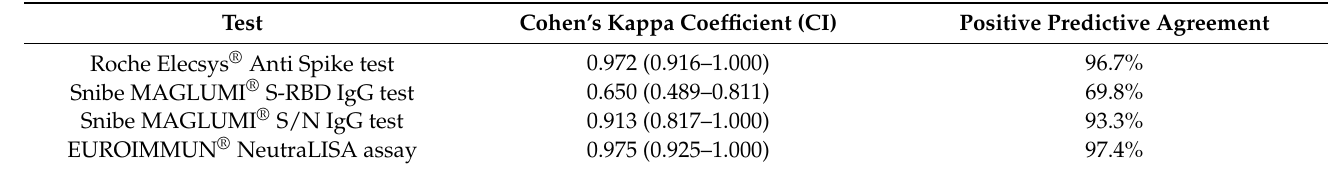
Table 5. Analyses of concordance relevant to each serological